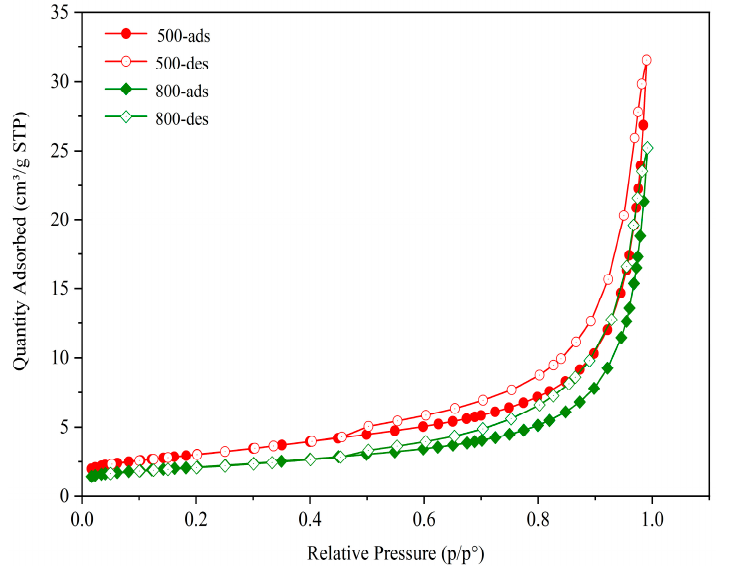
Figure 9. Isotherms of N 2 adsorption and desorption on the CG-500 sample (calcined at 500 °C) and CG-800 sample (calcined at 800 °C).